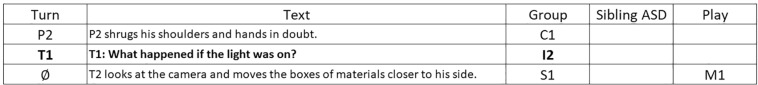
T1 – Significant pattern example.